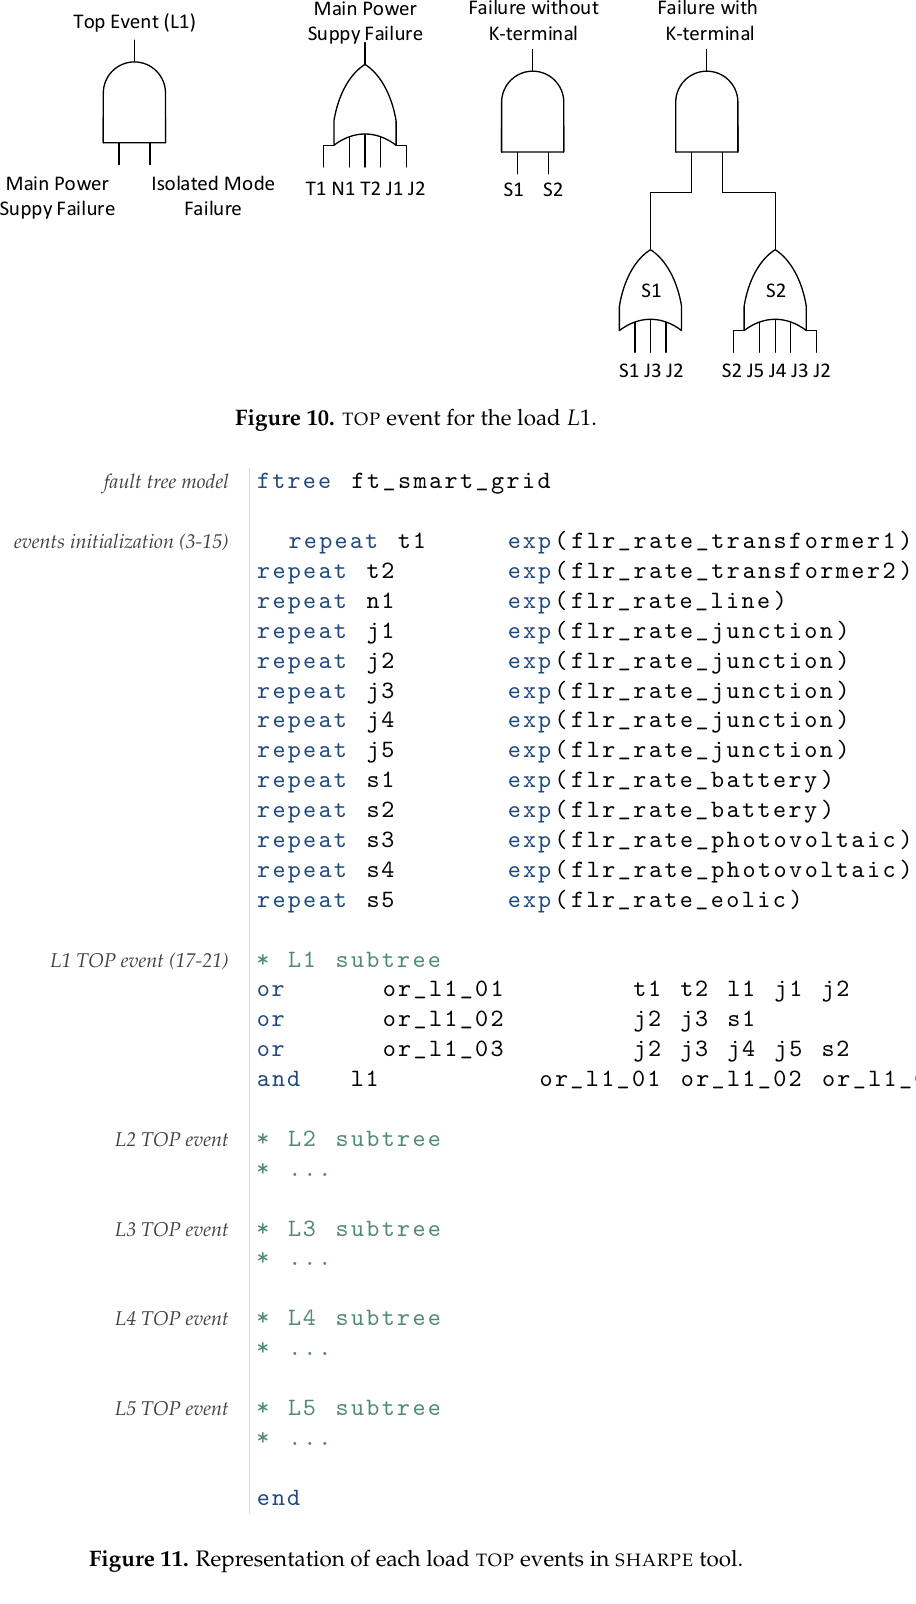
Figure 11. Representation of each load TOP events in SHARPE